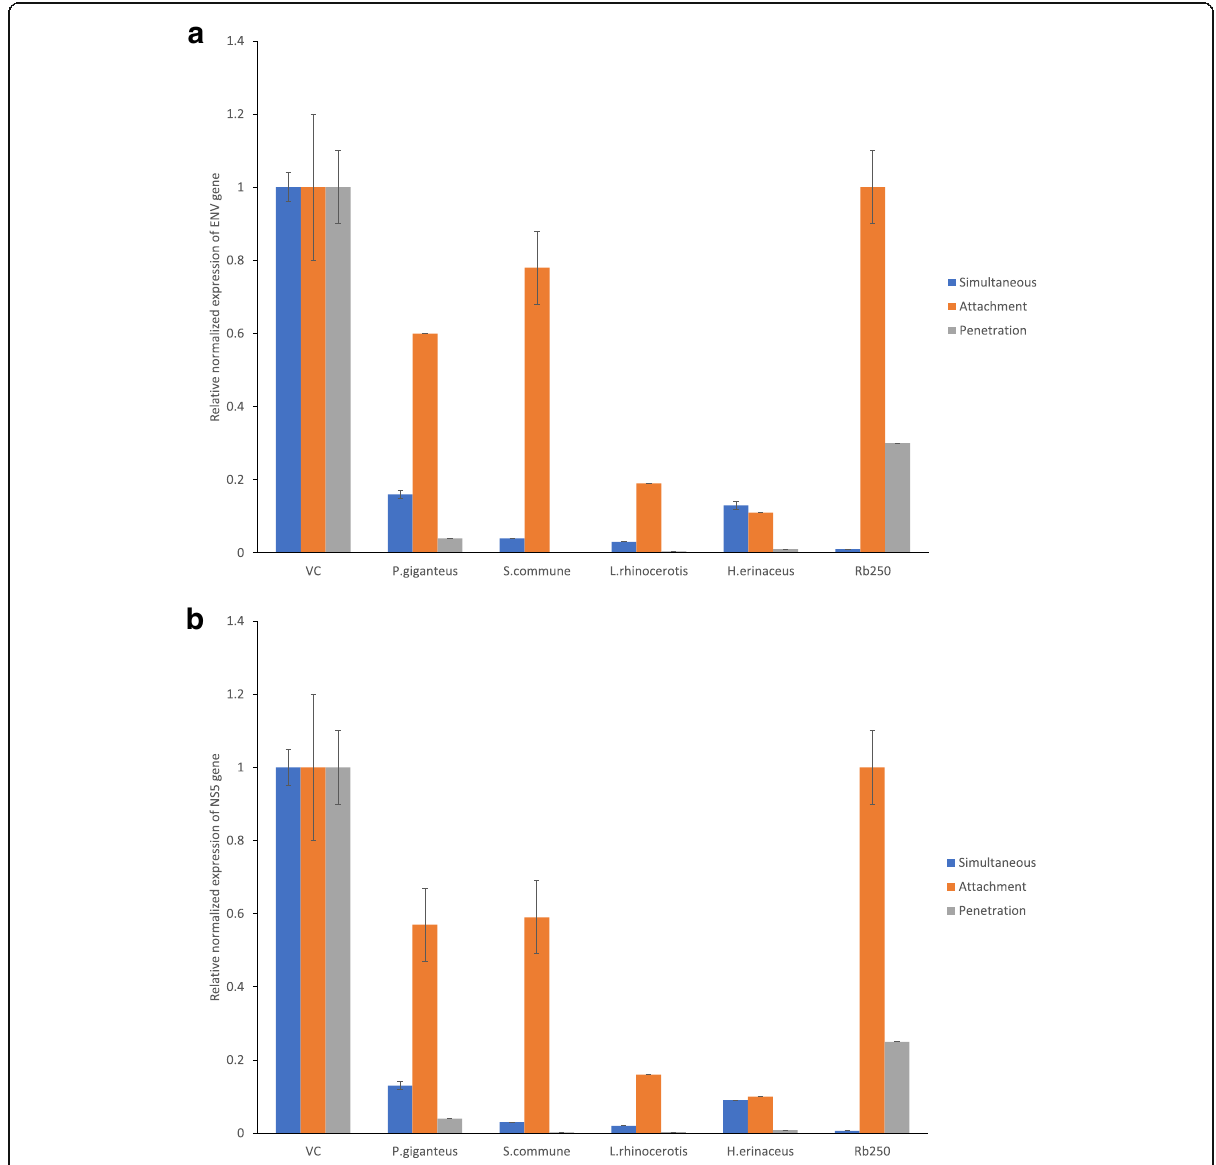
Fig. 3 a Expression of ENV gene in DENV infected cell after treated with mushroom extract. b Expression of NS5 gene in DENV infected cell after treated with mushroom extract. DENV-2 infected Vero cells were treated with 2000 μ g/ml mushroom extracts according to the protocol of simultaneous, attachment and penetration assay. After 48 h post infection, supernatants were collected to extract viral RNA of the mock infected cells, infected cells and treated infected cells. RT-qPCR was carried out to access the expression of ENV and NS5 gene. Gene expression was calculated using the algorithm provided by Bio-Rad CFX Manager Software 1.6. Results were normalized by GAPDH expression and were presented as relative normalized fold expression to virus infected cells which was defined as 1. Data are expressed as mean normalised fold expression ± SEM of two independent experiment ( n = 2). Statistical differences compared to mock infected cells are noted with asterisk (* P < 0.05) or (** P <